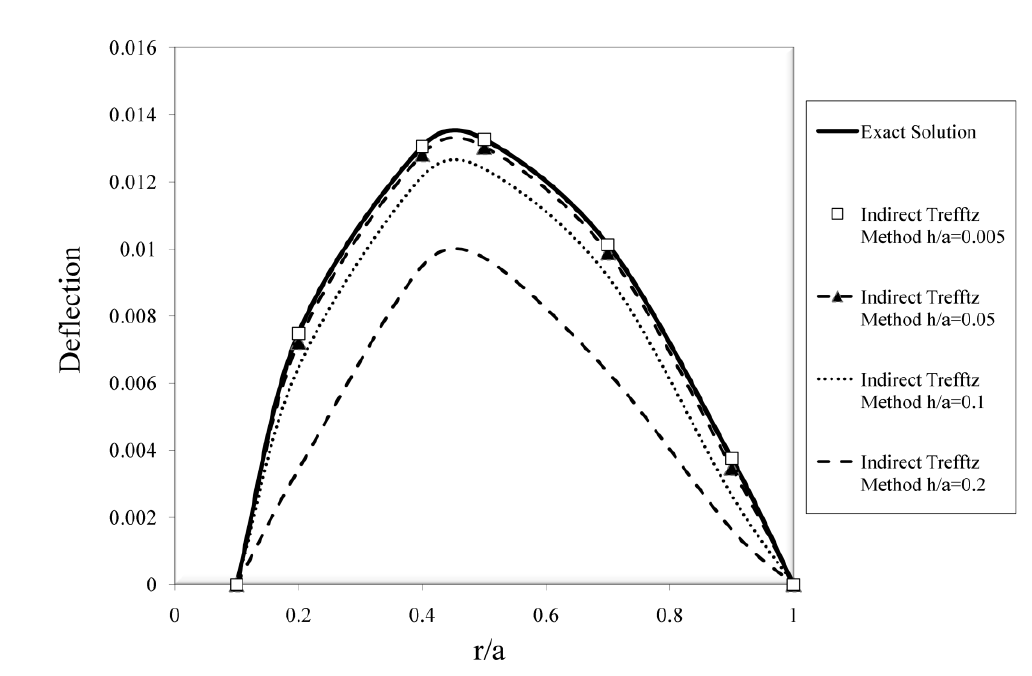
Fig. 6. Deflection of the annular plate with thickness ratio h/a ranging from 0.0005 to 0.2